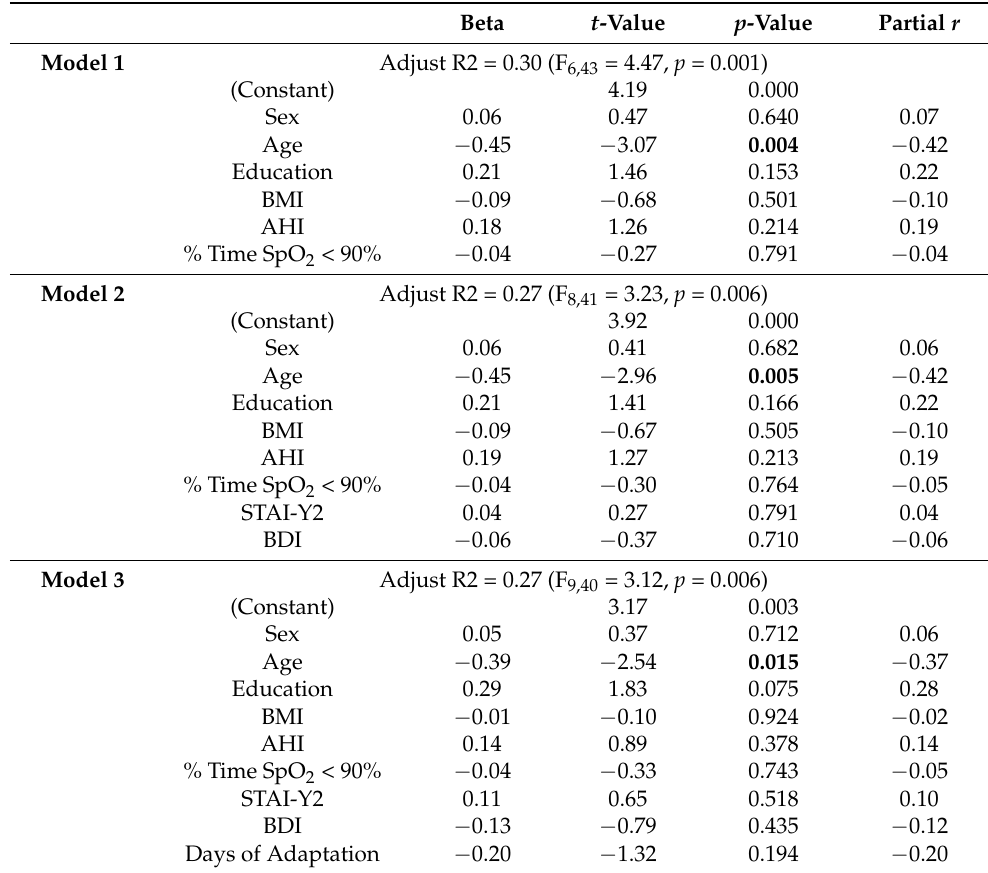
Table 6. Results of the hierarchical multiple linear regression analysis investigating the possible predictors of processing speed (i.e., SDMT score). Adjusted R 2 and F-statistics are reported for each model. Standardized Beta, t -values, p -values, and partial r correlation coefficients are reported for each predictor in each model. BMI: body mass index; AHI: apnea-hypopnea index; % Time SpO 2 < 90%: cumulative time spent with peripheral blood oxygen saturation (SpO 2 ) below 90%; STAI-Y2: State-Trait Anxiety Inventory form Y2; BDI: Beck Depression Inventory. Bold means significant results ( p ≤